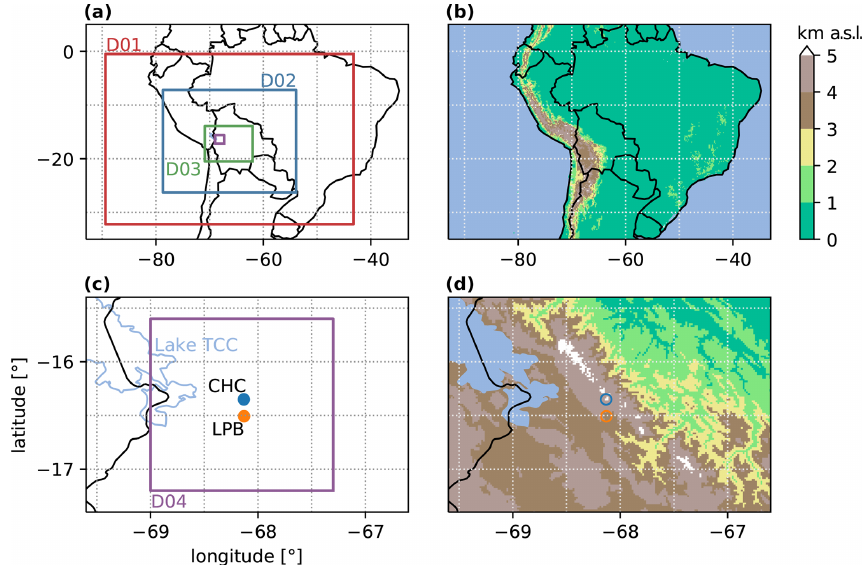
Figure 2. Overview of the studied region and the WRF model domains. Panel (a) shows the location of the four nested domains (D01–DO4); (b) shows the topography in kilometres above sea level (kma.s.l.) of the whole domain; (c) is a zoomed-in version of (a) and also shows the location of the Chacaltaya station (CHC; 5.2kma.s.l., blue dot), La Paz–El Alto metropolitan area (LPB; 3.6kma.s.l., orange dot) and Lake Titicaca (TCC; 3.9kma.s.l., blue outline). Panel (d) shows the topography (kma.s.l.) in the area closest to